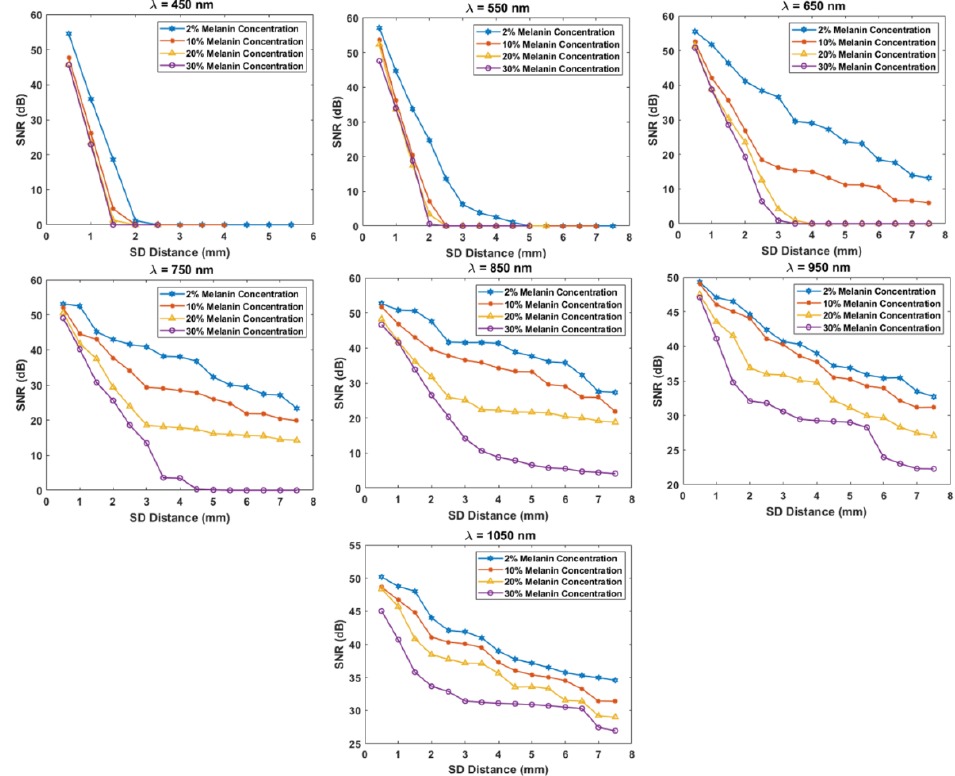
Figure 5. Calculated SNR for all different melanin concentrations, wavelengths, and SDSs.